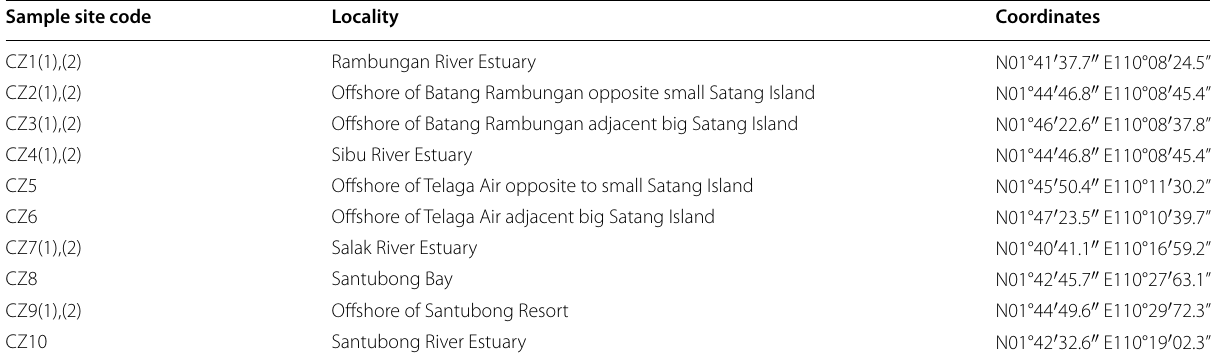
Table 1 Coordinates of sampling locations Sample site code